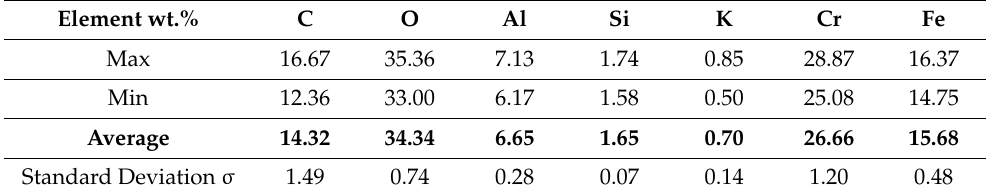
Table 4. Elemental wt.% contents of 5 min MR5M reclaimed sand in the analysed area (in Figure 7b). Element